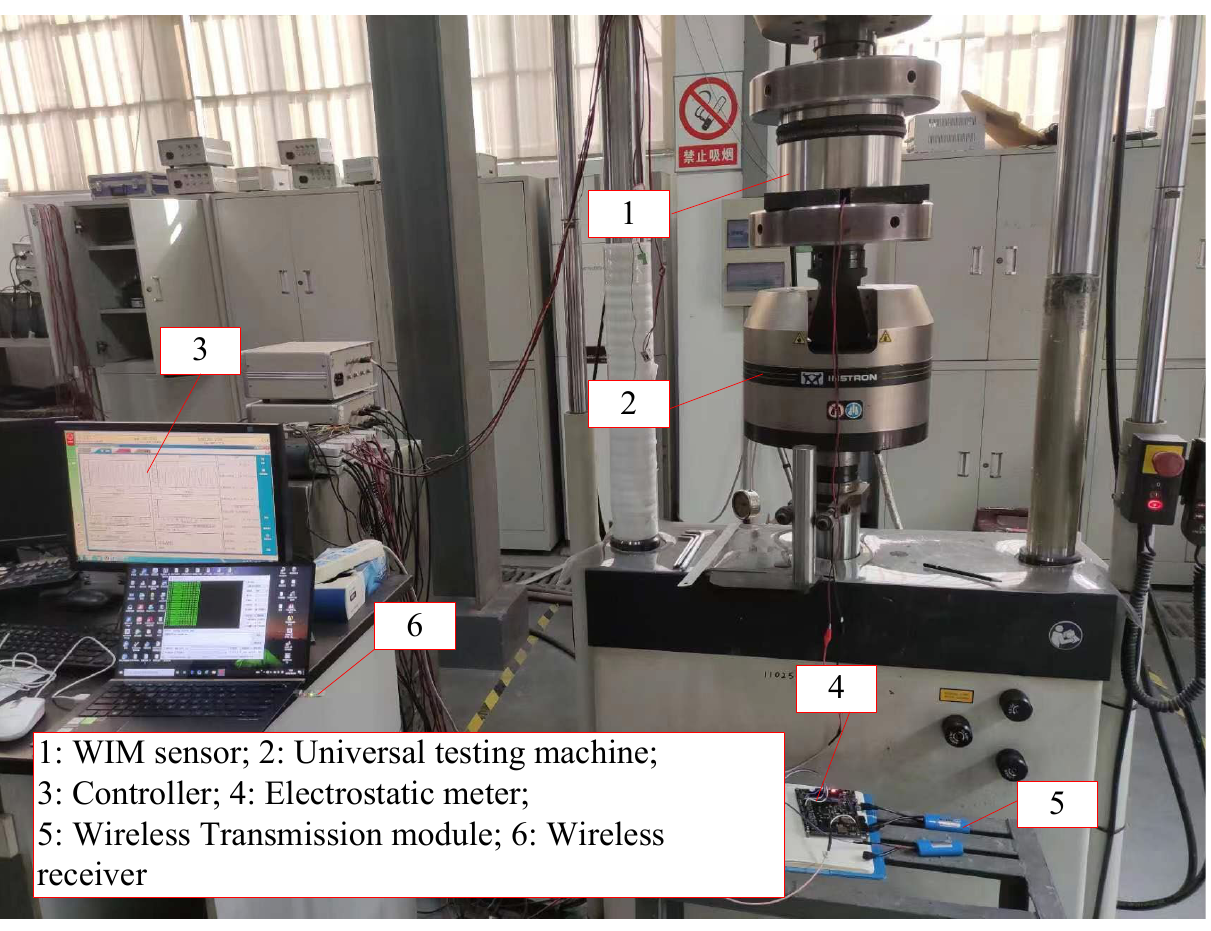
Figure 15. Establishment of dynamic load test platform.